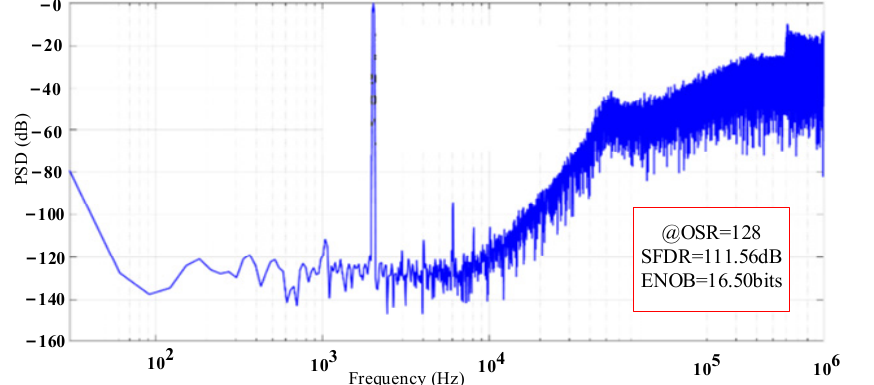
Figure 19. Power spectral density of the ΣΔ modulator.